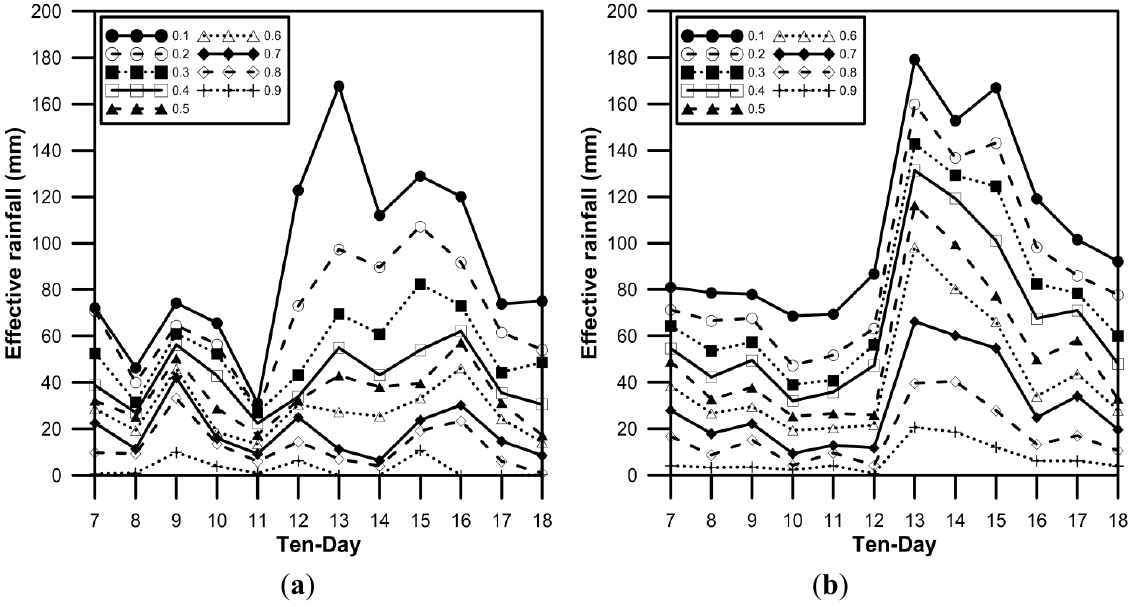
Figure 15. Exceedance probability distribution of effective rainfall at each ten-day during the first cropping season. ( a ) present (2004–2011); ( b ) future (2046–2065).